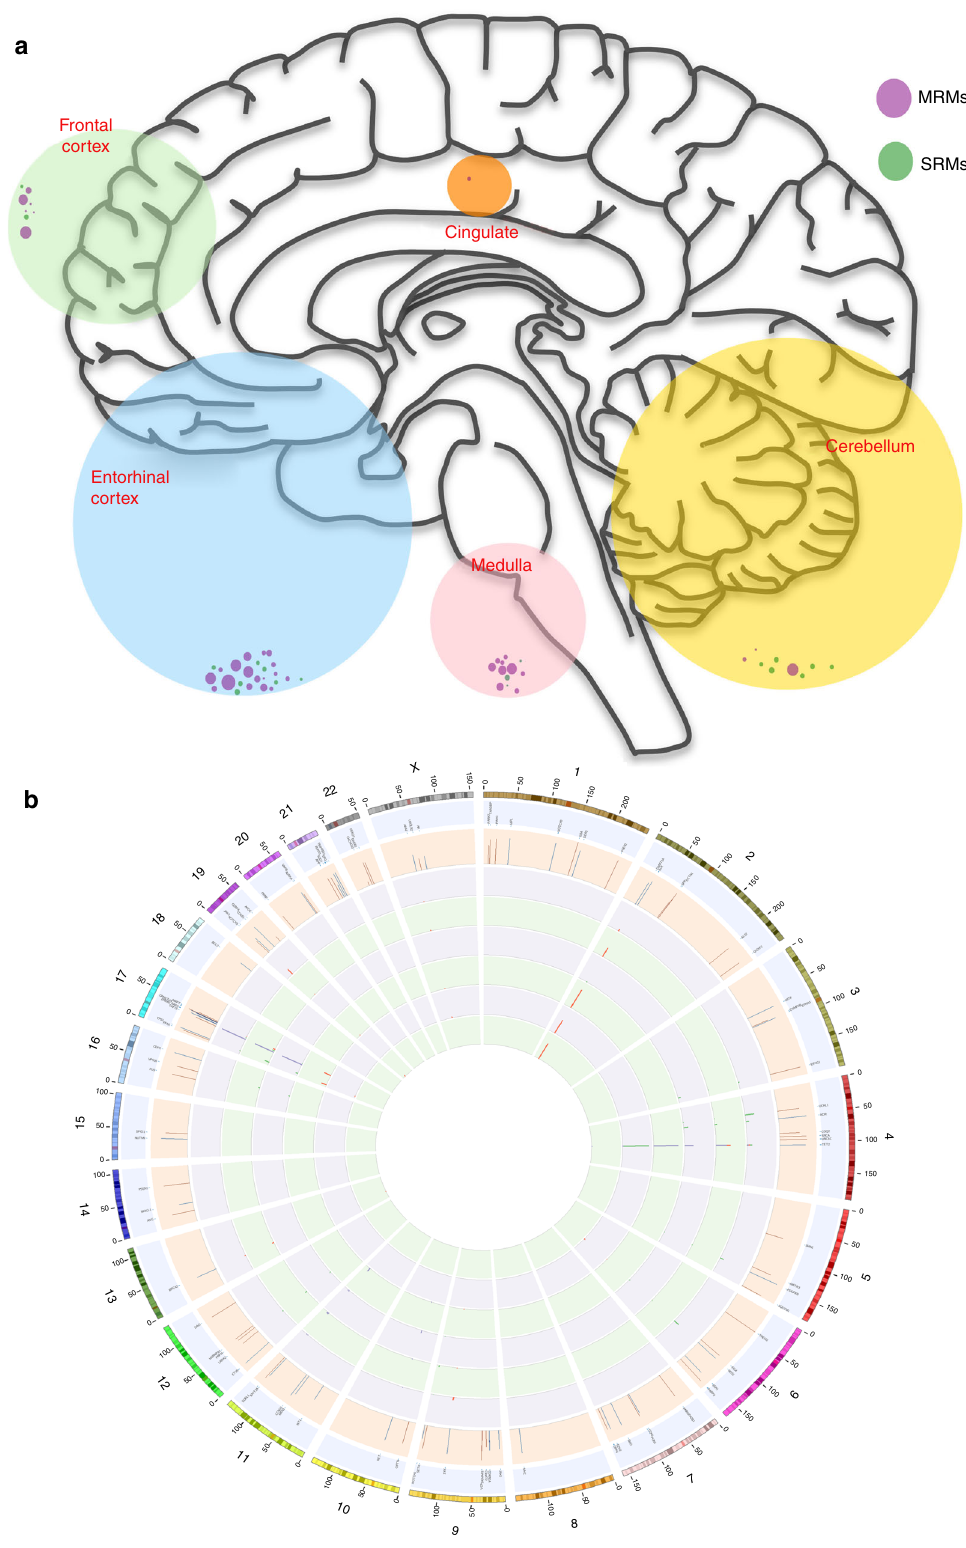
Fig. 4 Relative proportions of clonal mutations within brain regions. a Neuroanatomical origin of the brain samples sequenced. Large circle radii are proportionate to the number of DNA molecules sequenced in each region. Smaller circles represent the proportion of SRMs (green) or MRM (purple) detected within that region in the 54 brains. b Circos plot showing the detected variants. Outer to inner: genomic positions on the autosomes and X- chromosome; 102 genes sequenced; mean sequencing depth for each gene; VAF in the cerebellum; VAF in the entorhinal cortex; VAF in the frontal cortex; VAF in the medulla; VAF in the cingulate; and VAF in the blood. Neurodegenerative disease gene mutations shown in red, and cancer gene mutations in